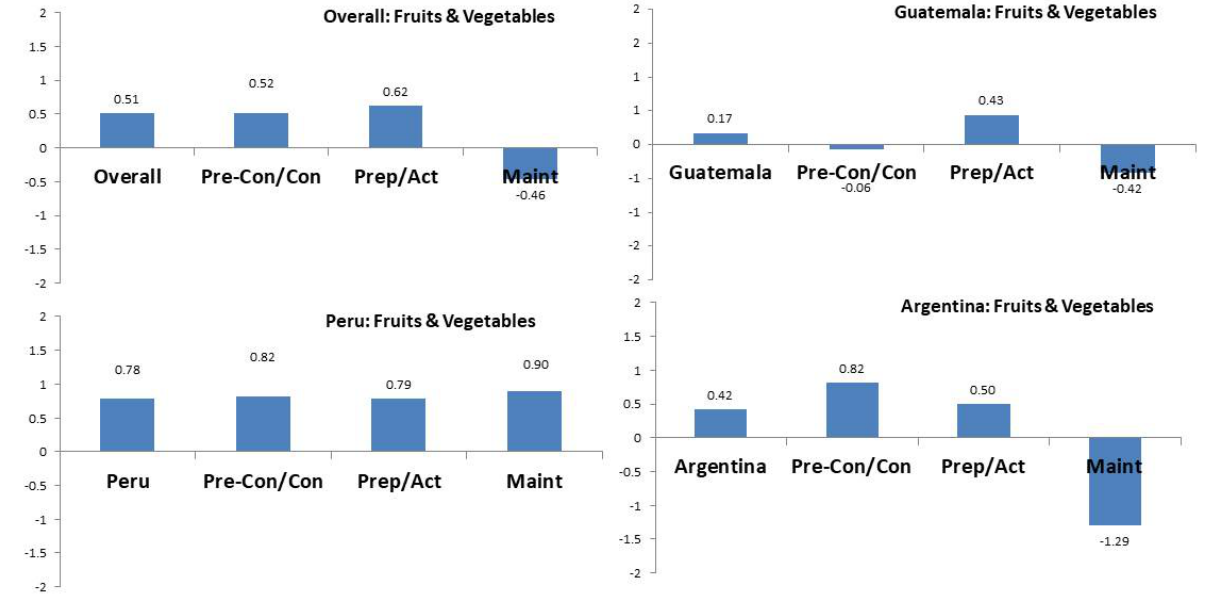
Figure 3. Intervention effect on fruit and vegetable consumption according to the participant baseline readiness to change status, overall and by country. Pre-Con/Con: precontemplation or contemplation; Prep/Act: preparation or action; Maint: